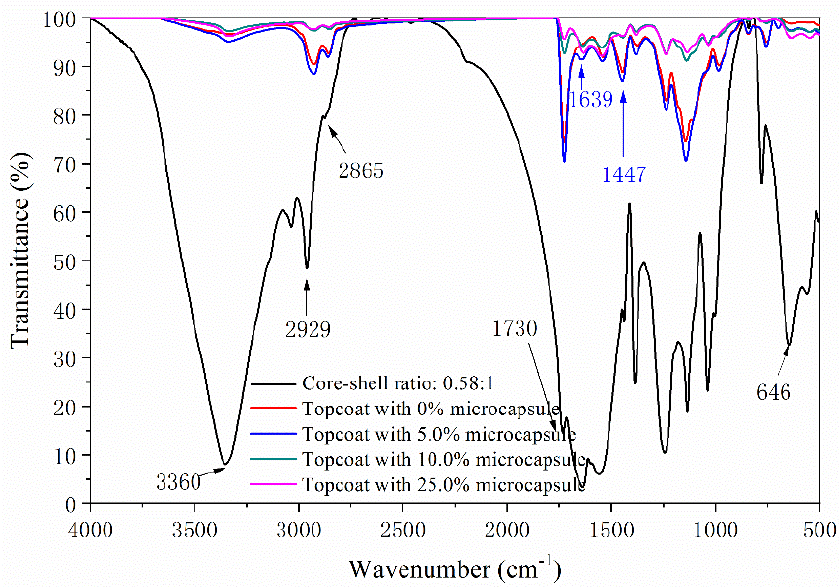
Figure 6. FTIR spectra of paint films with different concentrations of microcapsules (core-shell ratio = 0.58:1).